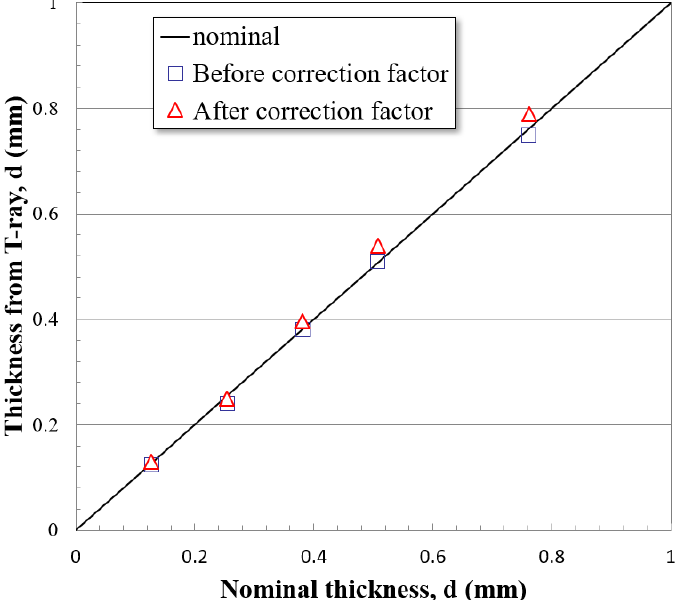
Figure 9. The relation between the nominal thickness and the thickness measured from the T-ray techniques in the Shim stock films.